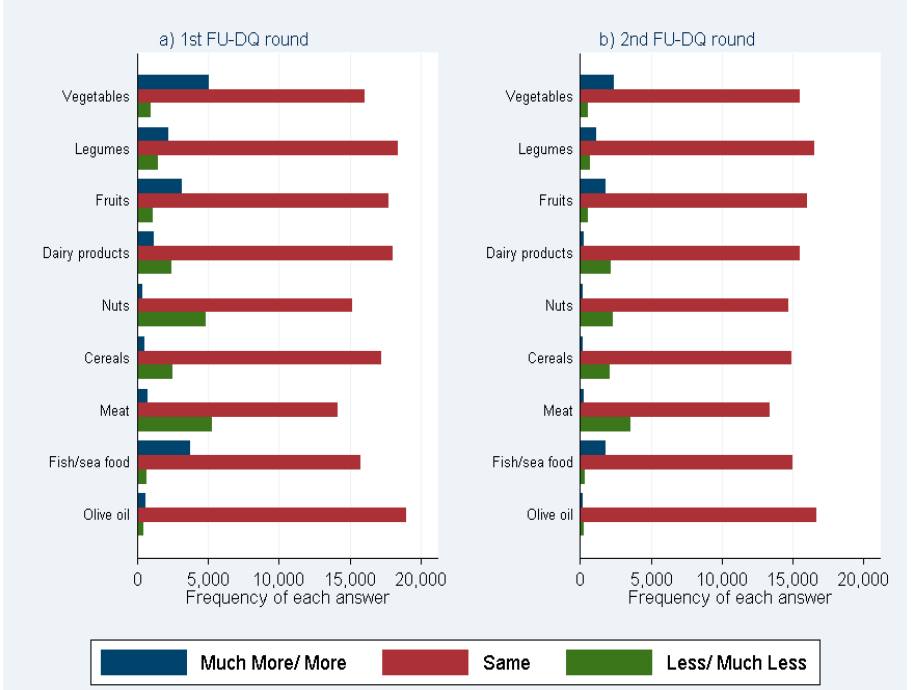
Figure 1. Bar plots for frequency of answers over the food items/groups of interest for the two rounds of the FU-DQ questionnaires: ( a ) first FU-DQ period; ( b ) second FU-DQ